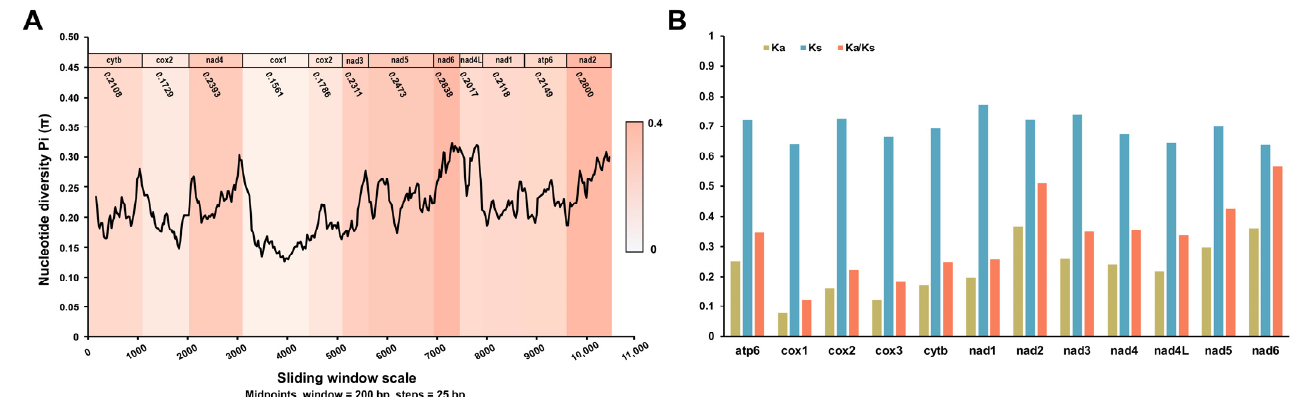
Figure 6. Evolutionary diversity analyses of the mtDNA among 40 Strongylida species including V. eleguneniensis . ( A ), Sliding window analyses of 12 PCGs. The black line shows the value of nucleotide diversity (Pi) in a sliding window analysis (200-bp sliding window with 25-bp step size); the Pi values of each gene are shown under the gene name and reflected by the heat maps on the background; ( B ), The evolutionary rates of 12 PCGs in Strongylida mtDNAs. The Ka, Ks, and Ka/Ks are calculated for each PCG.